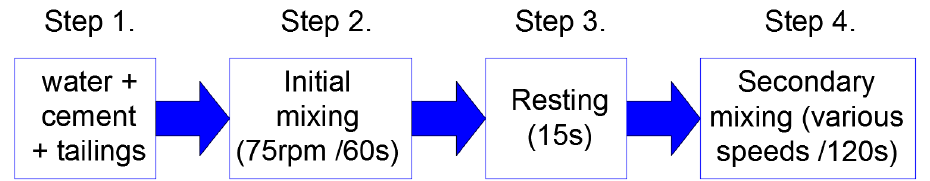
Figure 5. Mixing treatment to prepare CPB. Mixing speeds ranged from 75, 200, 300, 400, 500, and 600 rpm for Step 4.